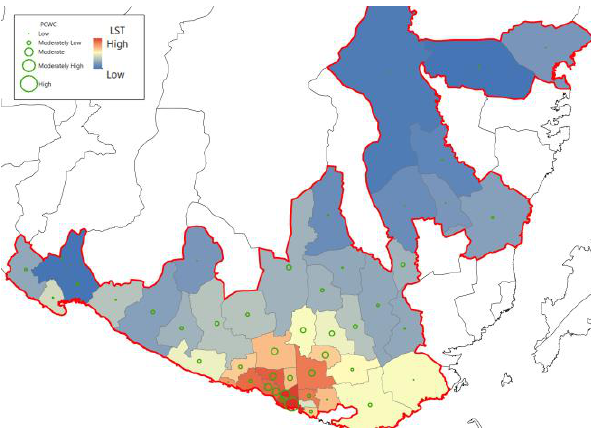
Figure 8. Spatial variation of barangay-averaged LST and PCWC data of the 49 barangays for April 2017